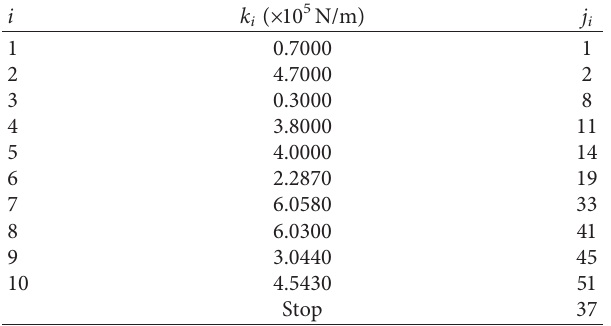
Table 6: Distribution of the coefficients of damping of the com- pliant ground.